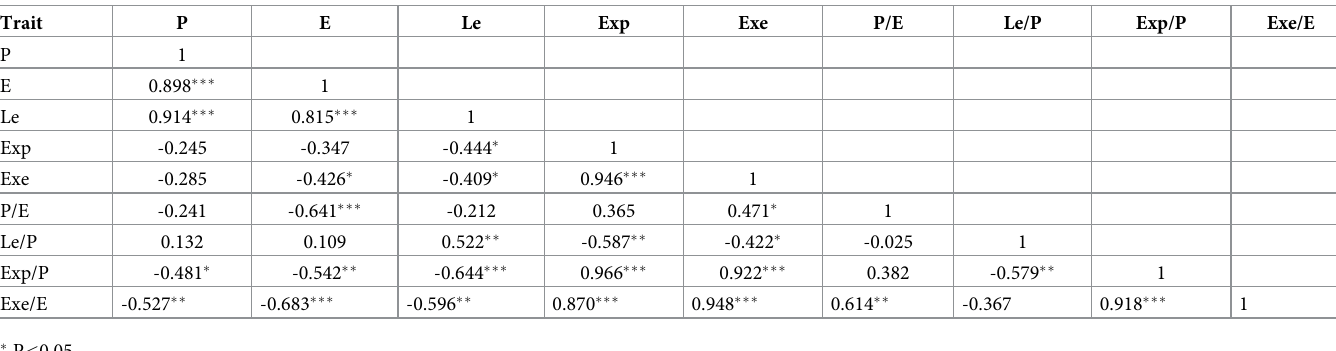
Table 7. Correlation coefficients between observed traits. Trait